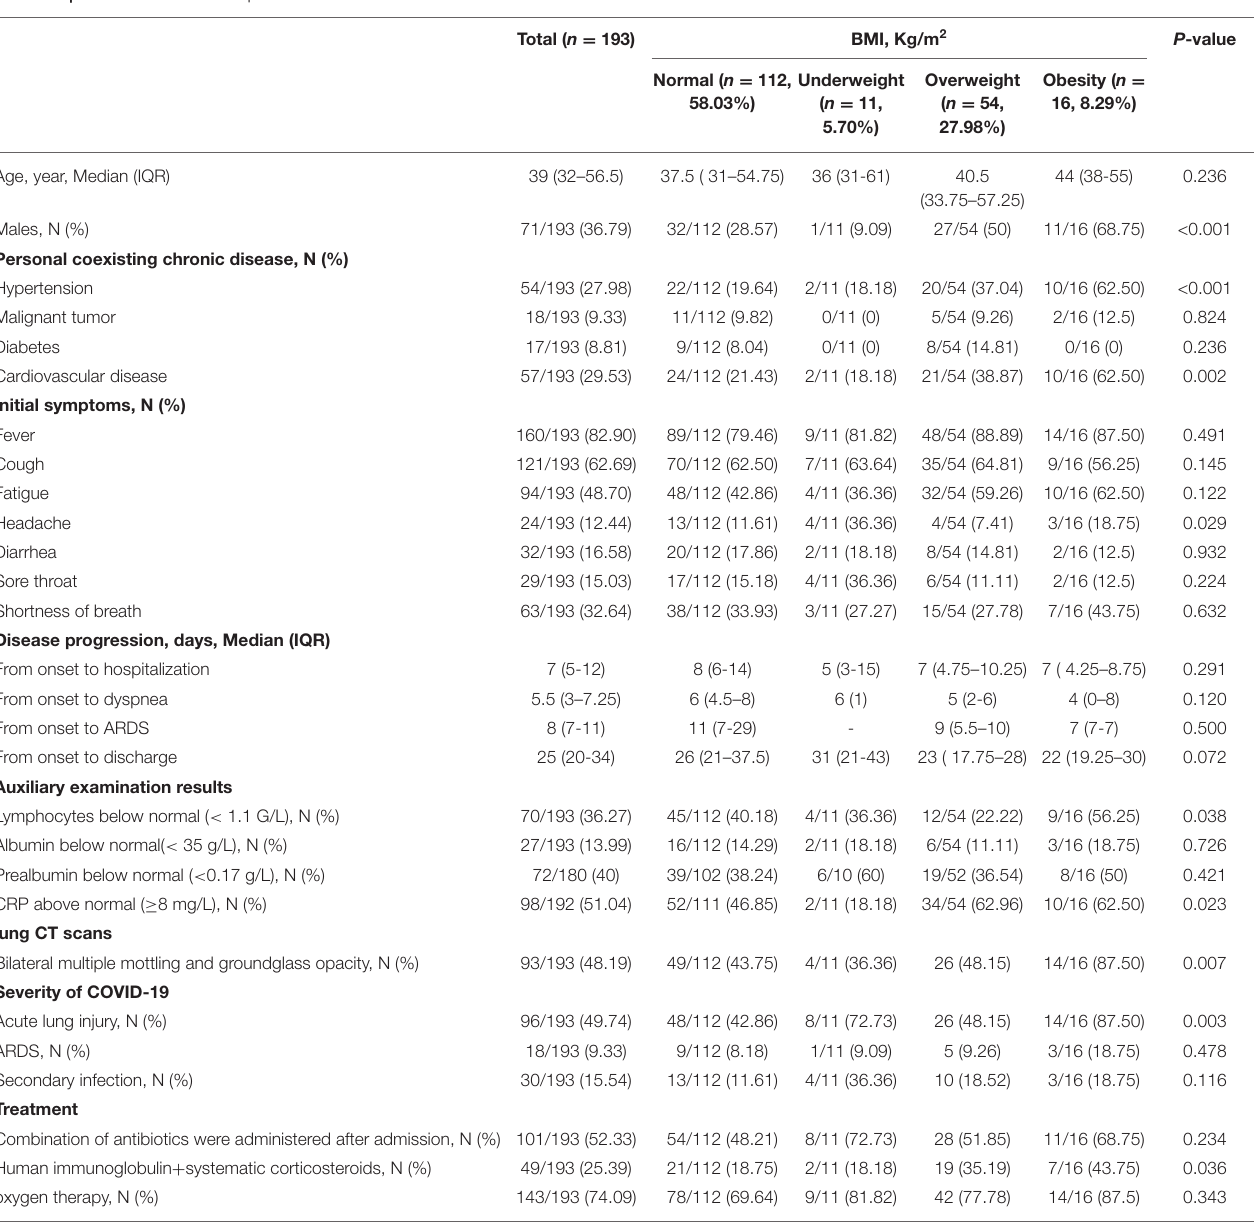
TABLE 1 | Characteristics of 193 patients with